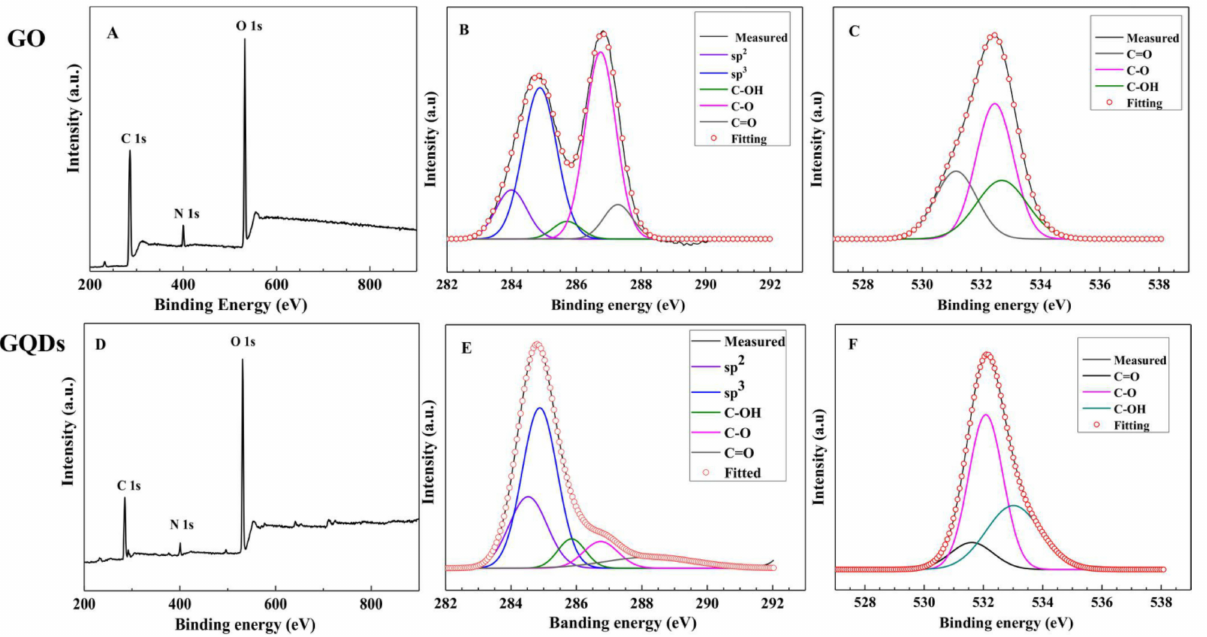
Figure 5. XPS spectra of GO (upper) and GQDs (lower). ( A , D ): survey scan spectra; ( B , E ): high resolution spectra of C1s; ( C , F ): high resolution spectra of